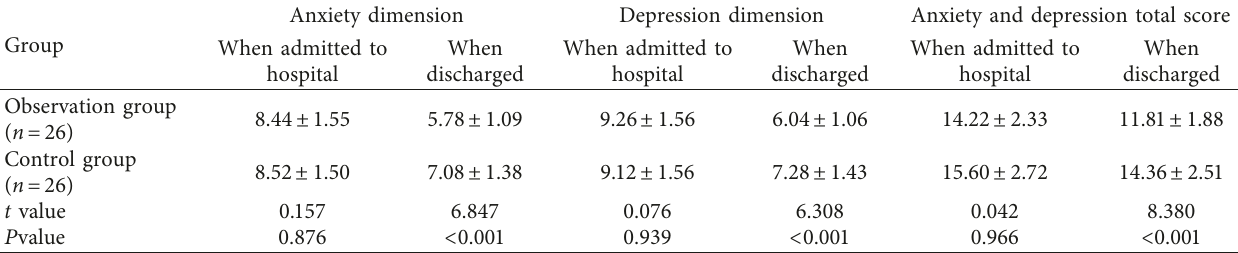
Table 2: Comparison of anxiety and depression levels between the two groups (score, x ± s ).